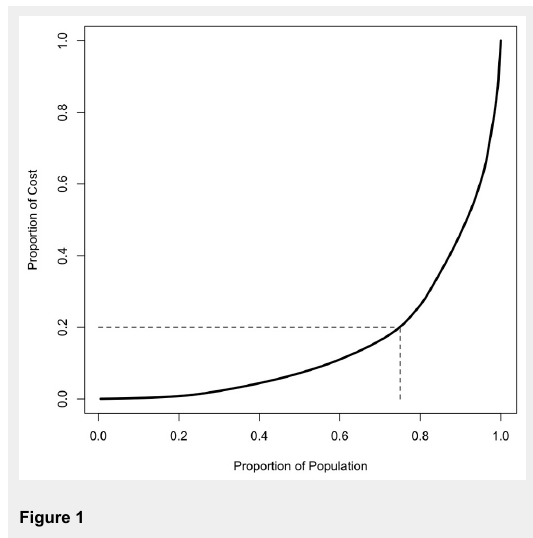
Concentration curve of direct medical costs of suicide attempts (n = 176).